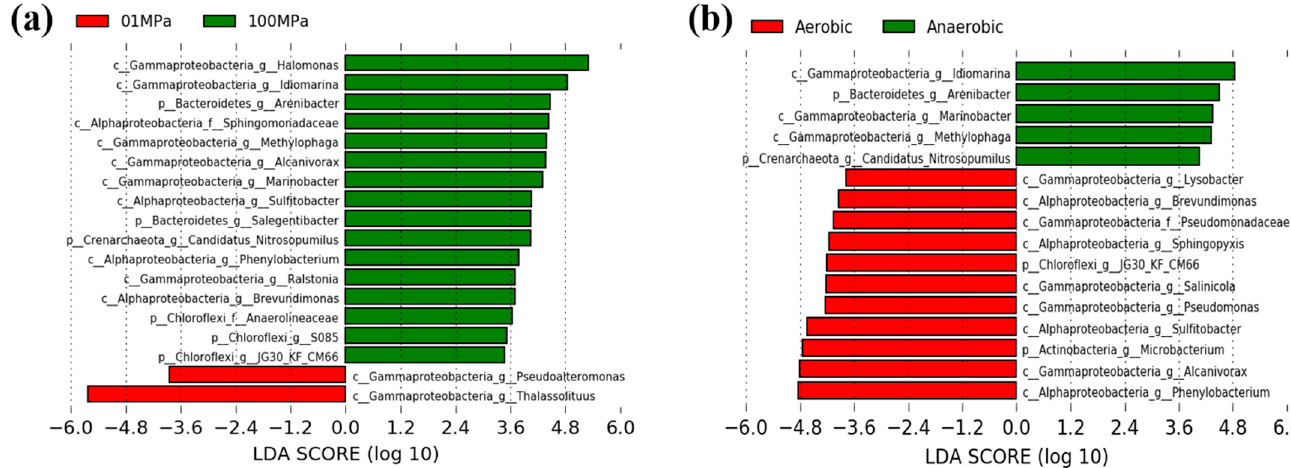
Figure 4. The linear discriminant analysis (LDA) identified the significantly different indicators between different pressure or oxygen treatments, with LDA scores of 5.0. ( a ) 0.1 MPa vs. 100 MPa; ( b ) aerobic vs. anaerobic.